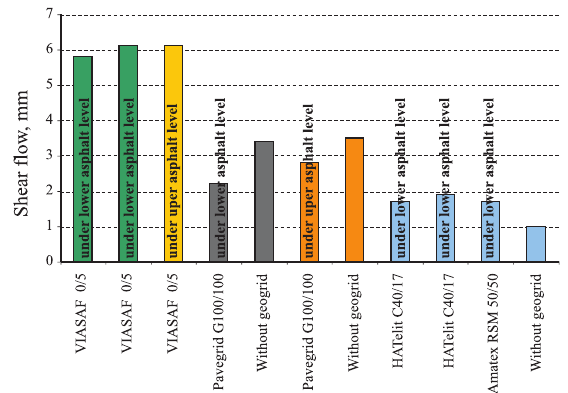
Fig. 4. Distribution of the shear flow of asphalt layers depending on geosynthetic material or special asphalt mixture at the interlayer was 35% lower than in the samples without geogrid, and the shear flow in the samples taken from the Kalvarijų g. with the identical geogrid between the upper and lower layers was 20% lower than in the samples without